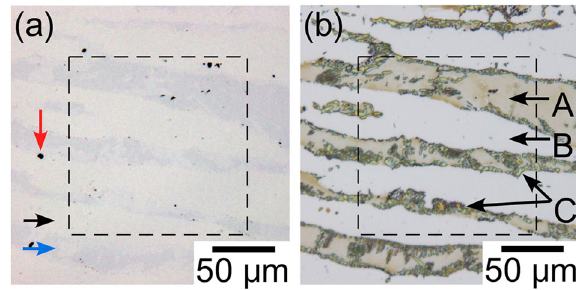
Fig. 3 Optical micrographs of the aged specimen. a As-polished and b after etching. An area with inclusions was